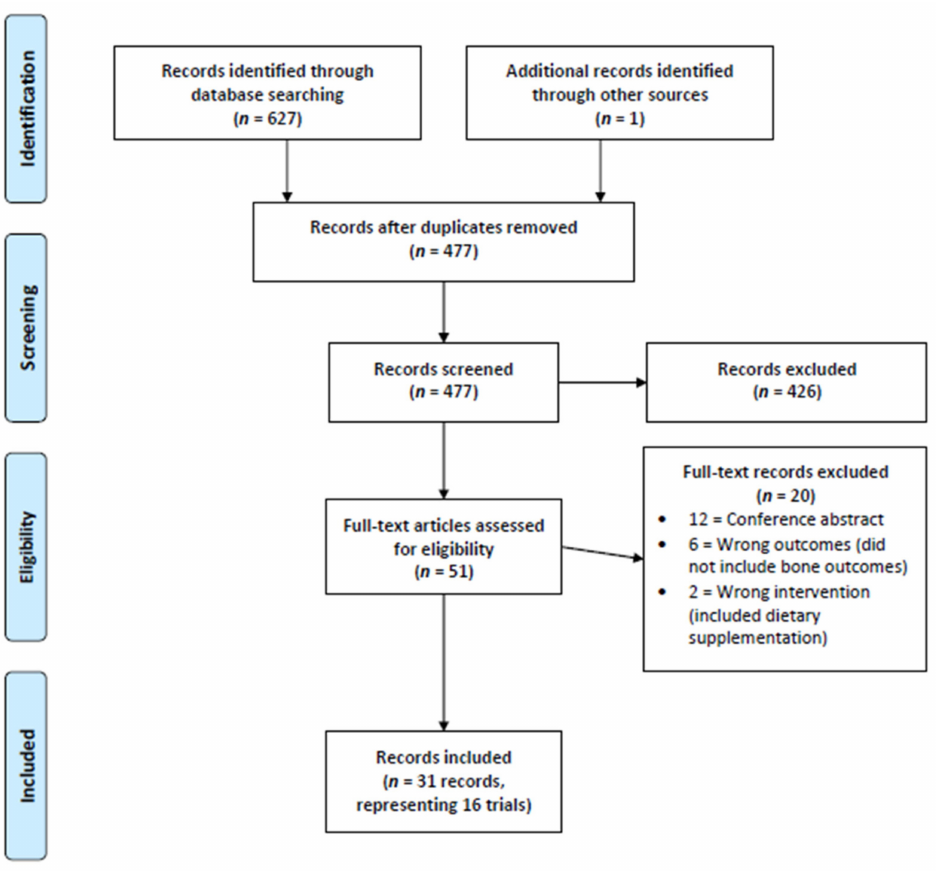
Figure 1. PRISMA Flow